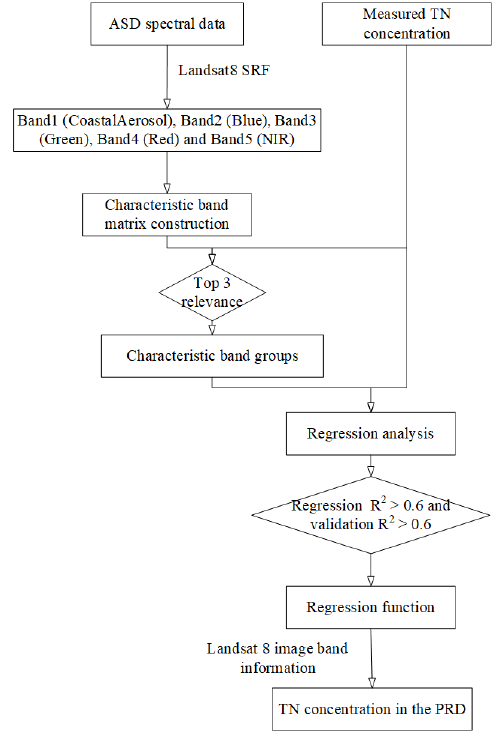
Figure 3. Flowchart of TN retrieval process.